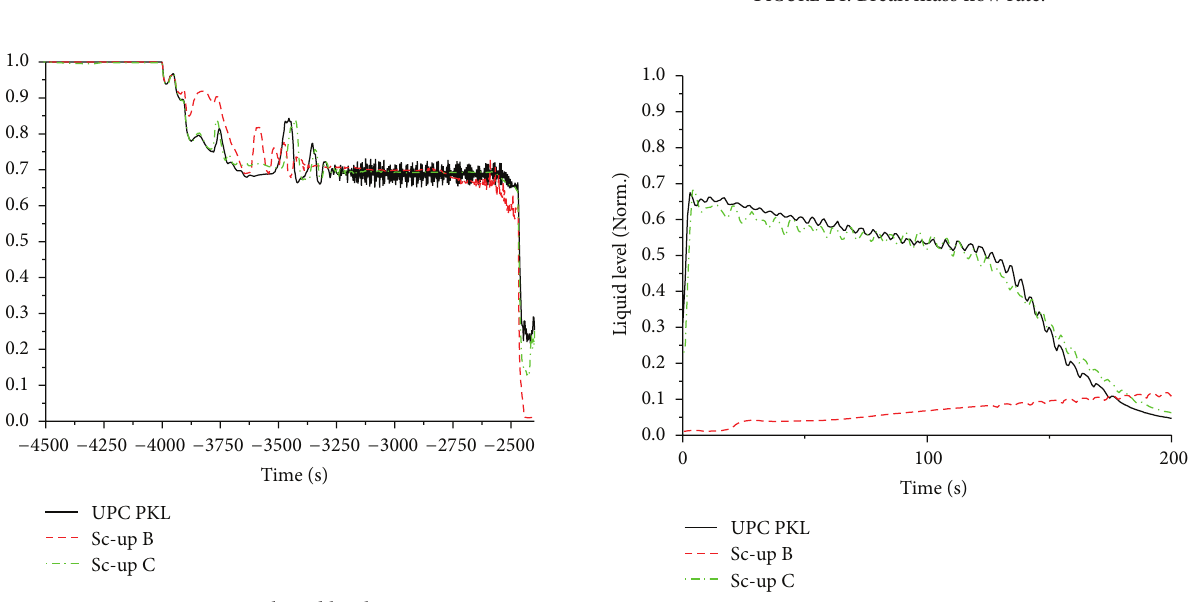
Figure 25: HL liquid